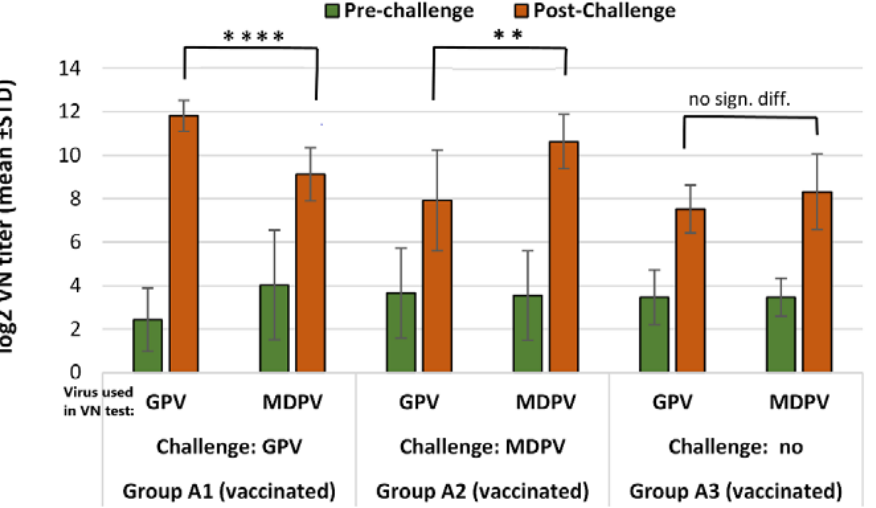
Figure 6. Humoral antibody response to GPV and MDPV in MDA-free ducks vaccinated with the bivalent vaccine, following challenge infection with GPV or MDPV strains at 2 weeks of age. The non-challenged vaccinated group (A3) was sampled at the same date when post-challenge samples were collected in groups A1 and A2, to determine the level of vaccine induced VN titers at the same time. Statistical comparison of post-challenge virus neutralization titers against GPV and MDPV indicated significantly higher titer increases against the virus homologous with the challenge virus (in case of GPV infection **** p < 0.0001; in case of MDPV infection ** p =